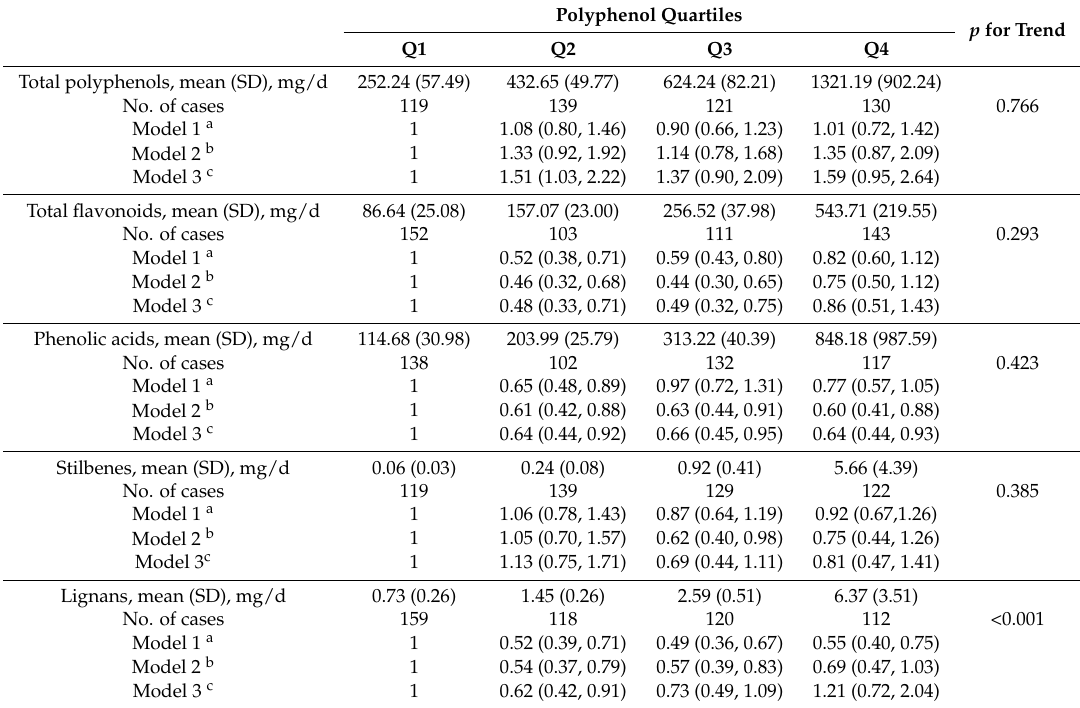
Table 2. Odds ratios (ORs) and 95% confidence intervals (CIs) for the association between polyphenol intake (total and main classes) and depressive